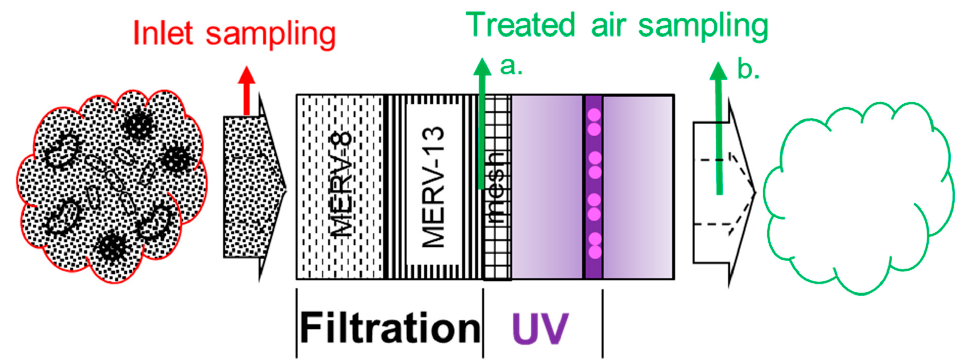
Figure 4. Details of FastAir prototype for air treatment (one symmetrical side shown) following the air flow direction. Treated air can be sampled after each treatment phase (e.g., filtration and UV) for PM and viable airborne bacteria. The red arrow indicates the air sampling location for the inlet (room air), and the green arrows indicate two air sampling locations for different configuration options: (a.) after “filtration only”, (b.) after “UV” or after “filtration + UV”.